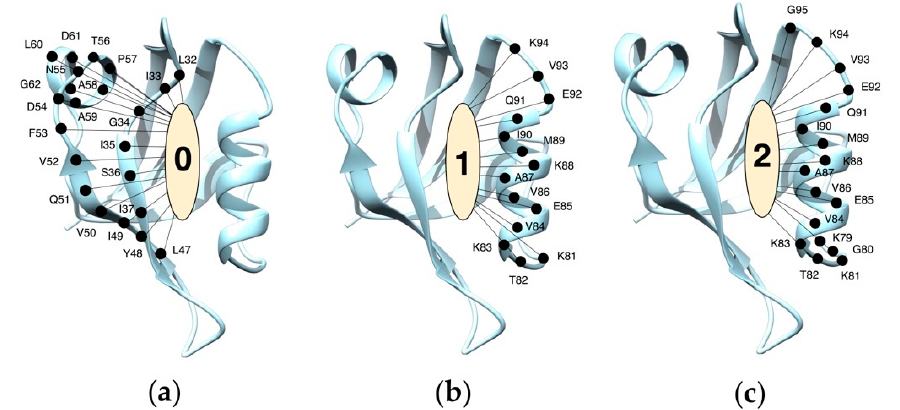
Figure 5. Protein network analysis across the three states of BIO124. ( a ) In State 0, the major motions of BIO124 couple with the β B strand, β C strand, and α A helix of the PICK1 PDZ domain. ( b ) In State 1, the major motions of BIO124 couple with the α B helix of the PICK1 PDZ domain. ( c ) In State 2, the major motions of BIO124 couple with the α B helix of the PICK1 PDZ domain.